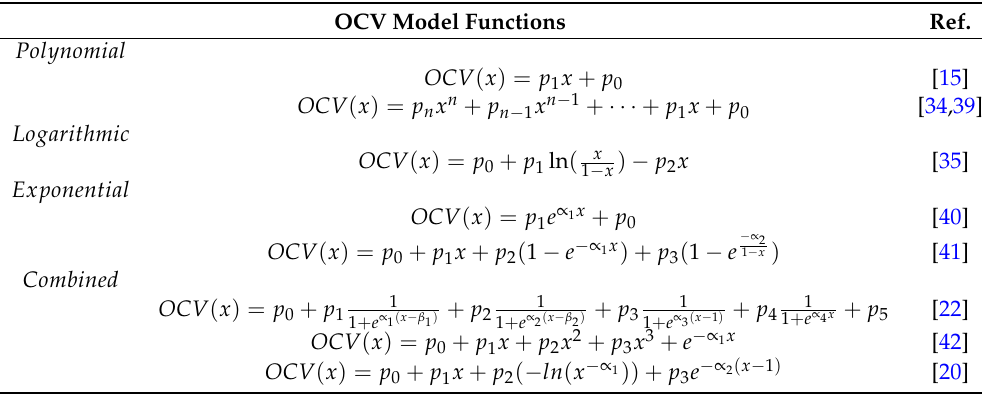
Table 1. Overview of OCV